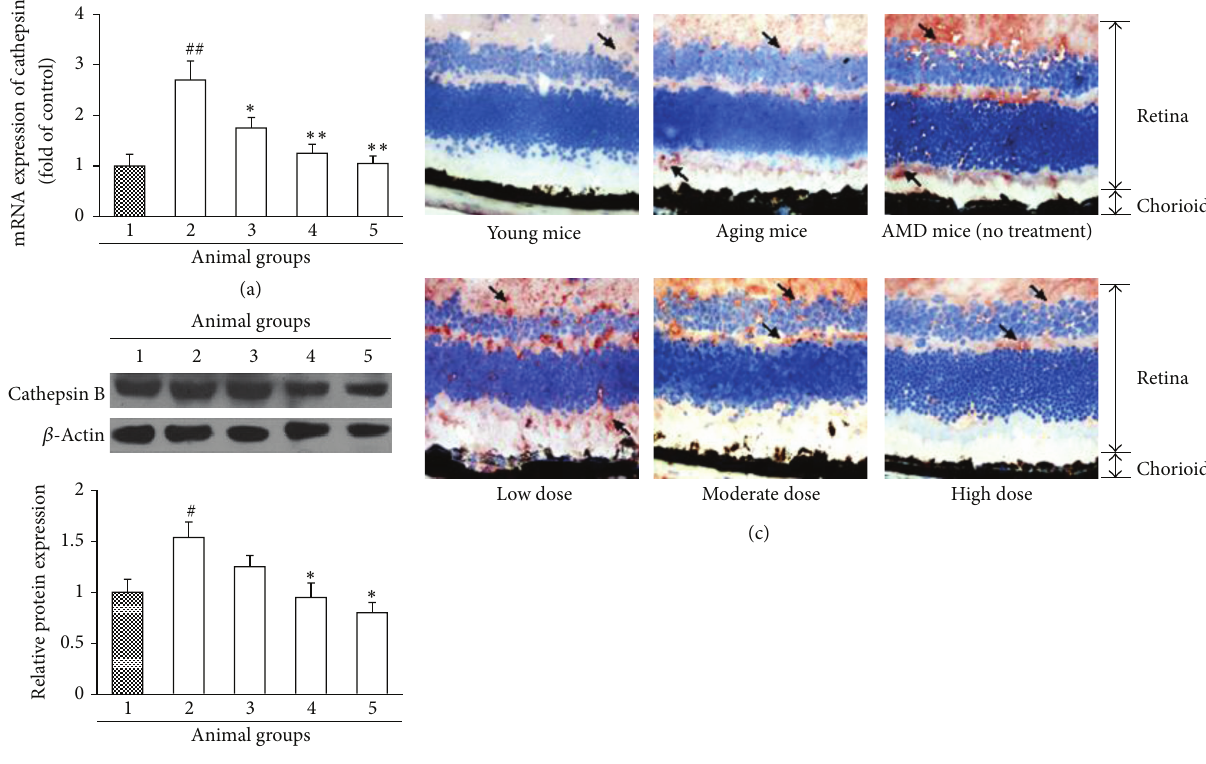
Figure 2: Effects of Fructus lycii ethanol extract on cathepsin B expression in mice with an experimental model of AMD. Mice were grouped: group 1, aging control group (no high-fat diet plus hydroquinone, no treatment); group 2, AMD model group (with high-fat diet plus hydroquinone, no treatment); group 3, low dose group (with high-fat diet plus hydroquinone, 1.25g/kg treatment); group 4, moderate dose group (with high-fat diet plus hydroquinone, 2.50 g/kg treatment); and group 5, high dose group (with high-fat diet plus hydroquinone, 3.75 g/kg treatment). (a) Real-time PCR analysis for transcript level of cathepsin B. GAPDH was used as the invariant control for calculating fold changes in mRNA levels ( 𝑛 = 10 ). Data are expressed as mean ± SD, ## 𝑃 < 0.01 versus group 1, ∗ 𝑃 < 0.05 versus group 2, and ∗∗ 𝑃 < 0.01 versus group 2. (b) Western blot analysis for protein level of cathepsin B. 𝛽 -Actin was used as an invariant control for equal loading. Representative blots were from 10 independent experiments with quantification. Data are expressed as mean ± SD, # 𝑃 < 0.05 versus group 1, and ∗ 𝑃 < 0.05 versus group 2. (c) Immunohistochemical staining of the eye tissues for cathepsin B was detected in different groups (magnification × 25000). Normal young mice (3 months old) were used as negative control. The retina and chorioid are